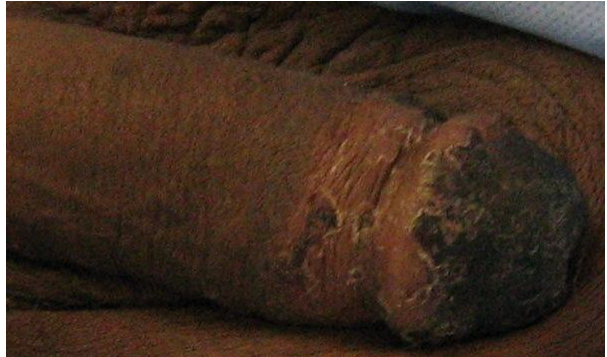
FIGURE 4. Result after 4 weeks of conservative management.